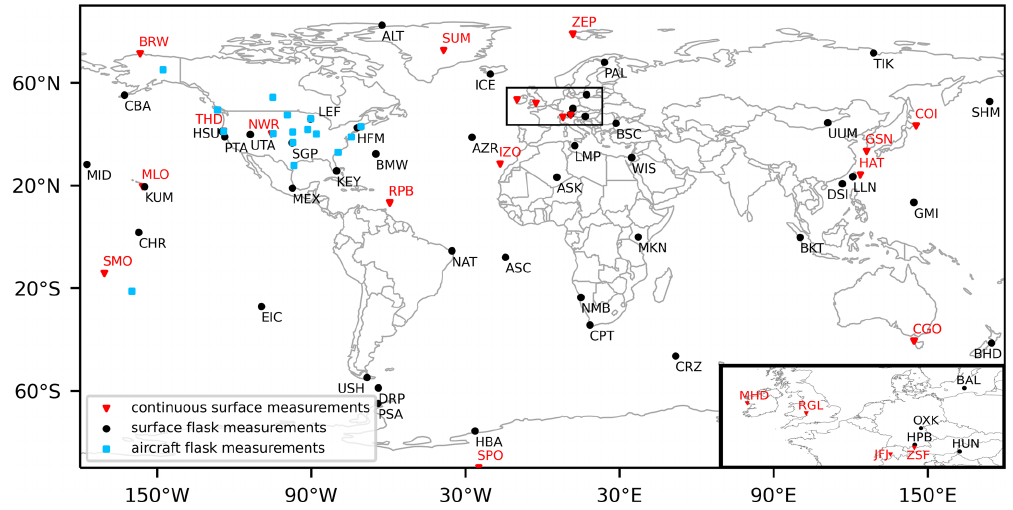
Figure 1. Map of sites with continuous surface measurements used for the inversion (red triangles) and flask measurements (surface: black dots, aircraft: blue squares) that were additionally used for the reanalysis of SF 6